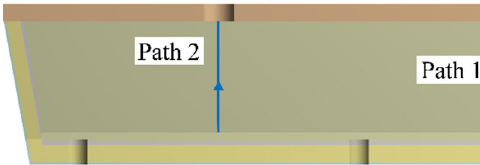
Figure 6. Path 1 and path 2.